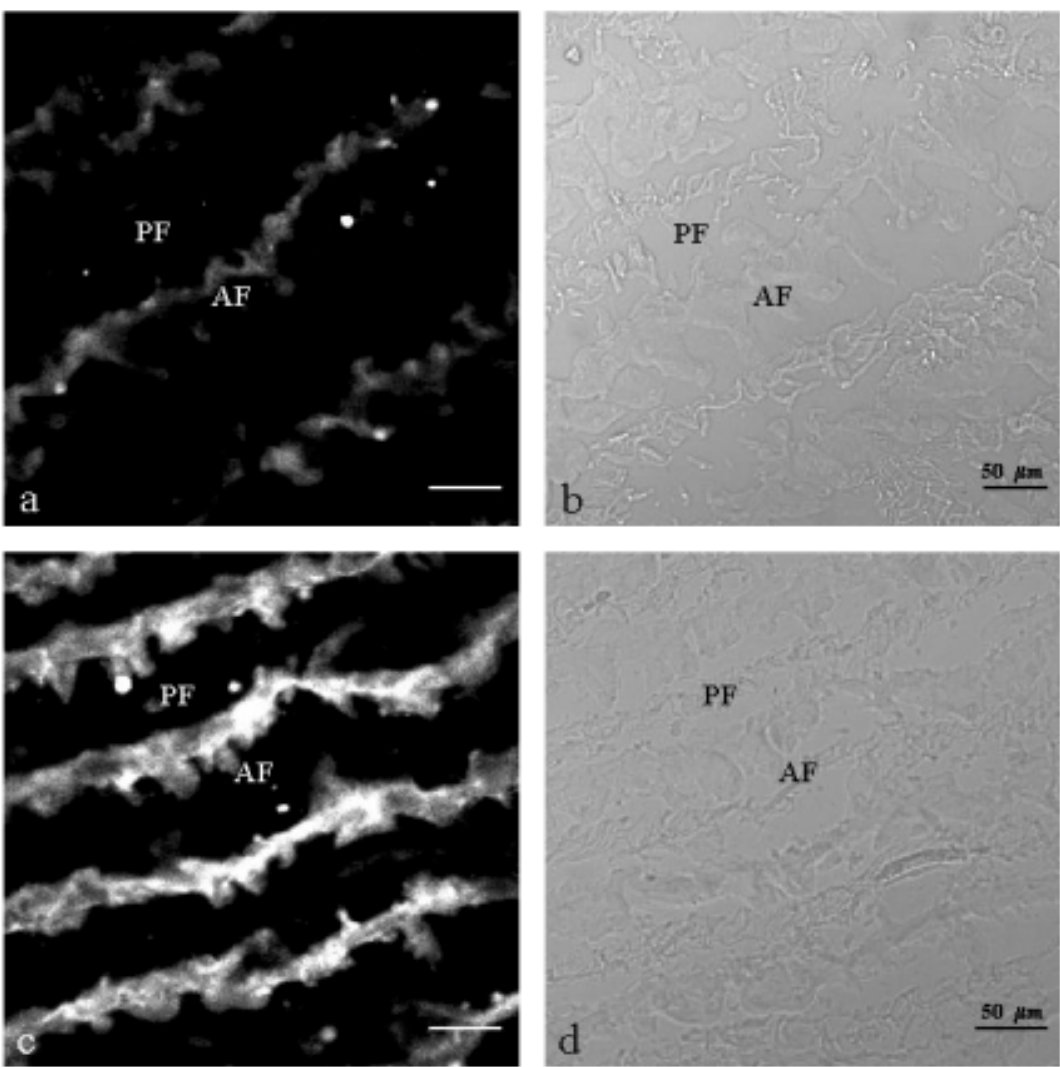
Fig. 1a-b – Thin section (10 µ m) of normal contralateral electric tissue; a: immunolabelled with policlonal antibody anti-ChAT. Immunoreactivity is essentially cytoplasmatic; b: phase contrast. AF; anterior face, PF; posterior face. Fig. 1c-d – Thin section (10 µ m) of denervated electric tissue ( 30 days ); c: immunolabelled with policlonal antibody anti-ChAT.A high increase of labelling in the cytoplasm is observed; d: phase contrast. AF; anterior face, PF; posterior